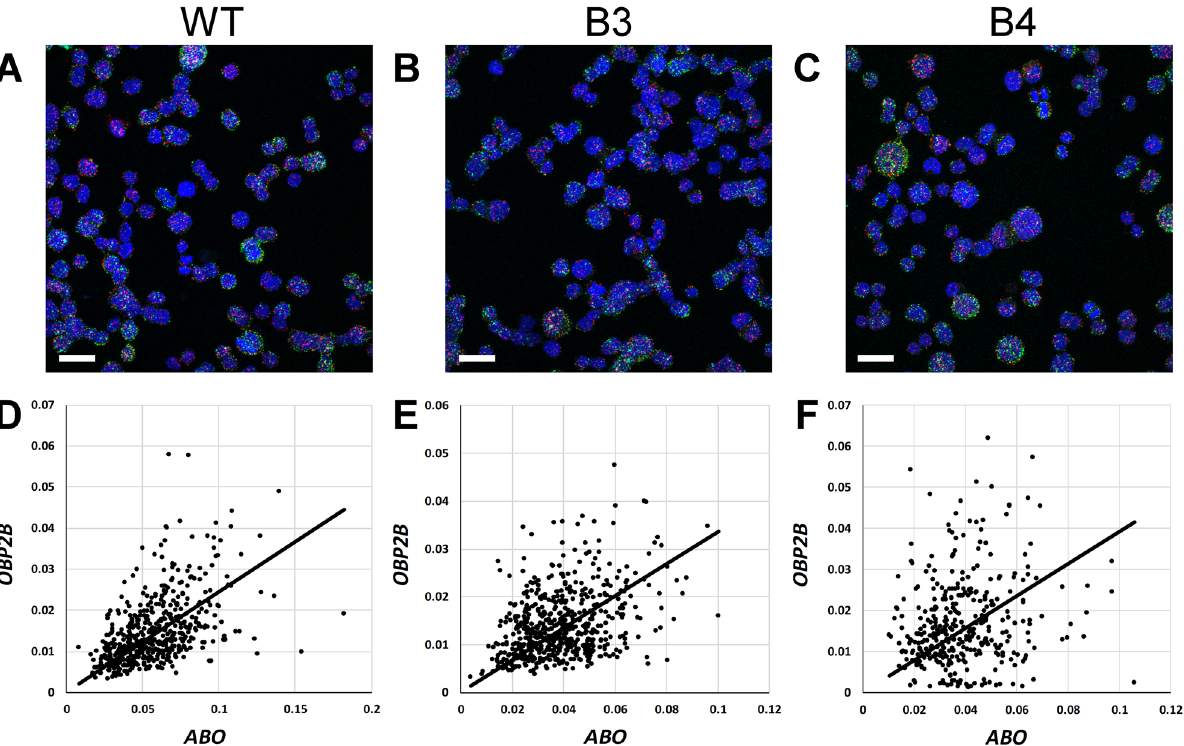
Figure 6. RNA fluorescence in situ hybridization for the ABO and OBP2B transcripts. ( A – C ) Representative images of the wild-type KATOIII cells ( A ), and their mutant clones B3 ( B ) or B4 ( C ) fluorescently labeled for transcripts ABO (Opal570; shown in red) and OBP2B (Opal520; green), as well as nuclei (DAPI; blue). Scale bar; 20 µm. ( D – F ). Mean relative intensity of the ABO and OBP2B signals in each nucleus for the wild-type cells ( D ), B3 cells ( E ) or B4 cells ( F ). Each dot represents each ROI (nucleus), and the x-axis indicates the mean relative intensity of the Opal570 signal ( ABO ) in each ROI while the y-axis shows that of Opal520 ( OBP2B ). The coefficients of determination (R 2 ) were 0.812 for the wild-type cells, 0.802 for B3 cells and 0.666 for B4